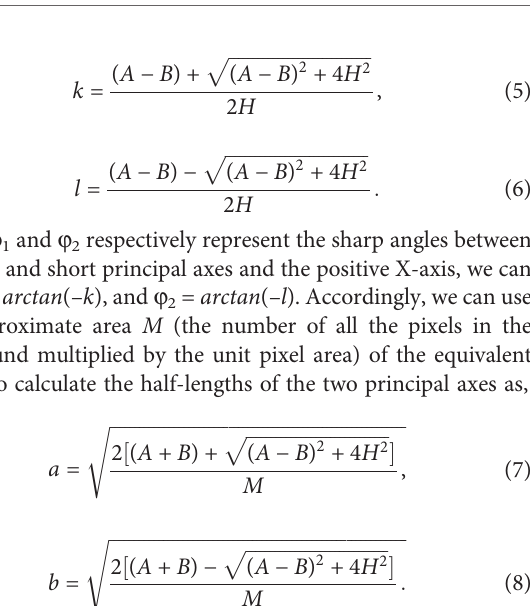
FIGURE 2 | Esophageal carcinoma approximately assessed by its corresponding equivalent ellipses. CT i and GroTr i ( i = 1,2 … , 10) denote the i th CT slice and its corresponding ground truth mask of tumor. The red ellipse is the equivalent ellipse of lesion. The white mask is the lesion mask. The intersection angles between the green line segment and the blue horizontal straightness represent the sharp angles between the long principal axes and the positive X-axis.